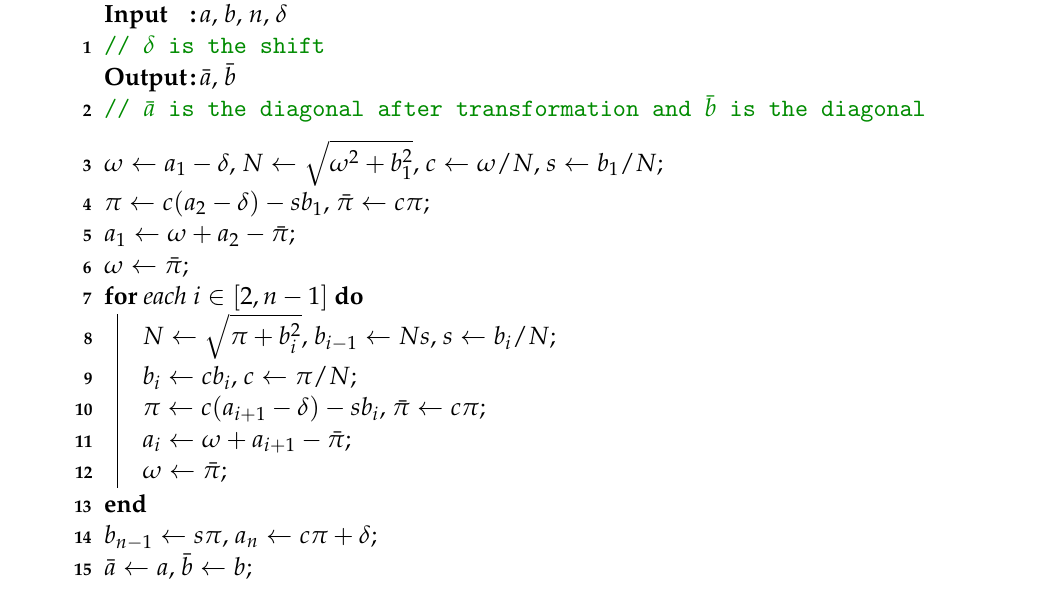
Algorithm 5 costs 6 n multiplications, 2 n divisions, and ( n